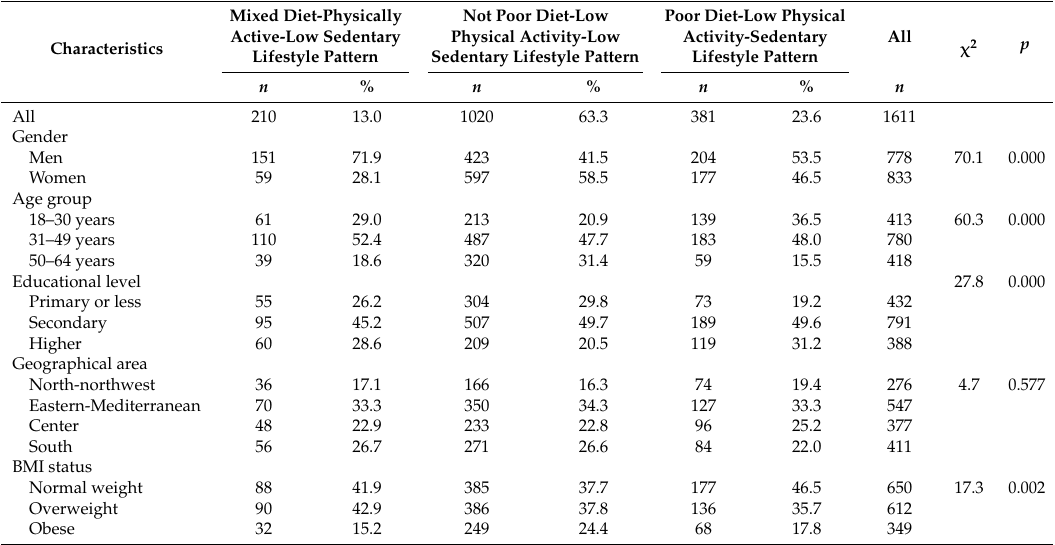
Table 1. Gender, age group, educational level, geographical area, and BMI status by lifestyle pattern.